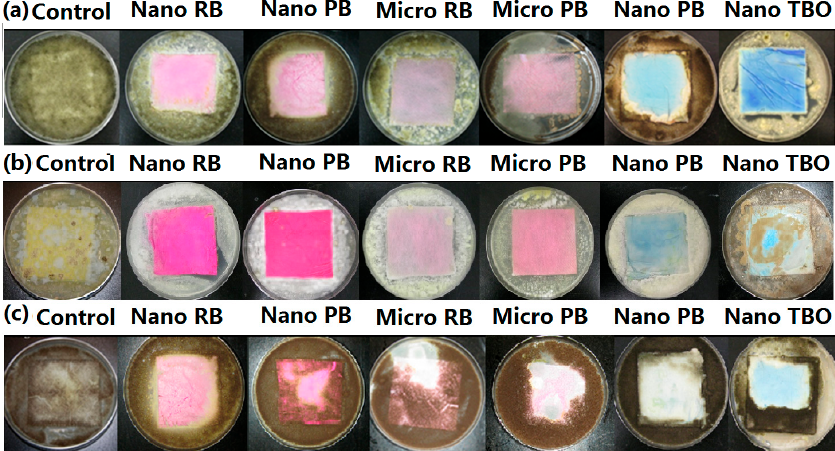
Figure 3. The inhibition zone test of nano and micro fabric grafted with RB, PB, AA and TBO on ( a ) P. cinnamomi ; ( b ) T. viride ; and ( c ) M. grisea , The 1st column is the control, the 2nd is the nano fabric